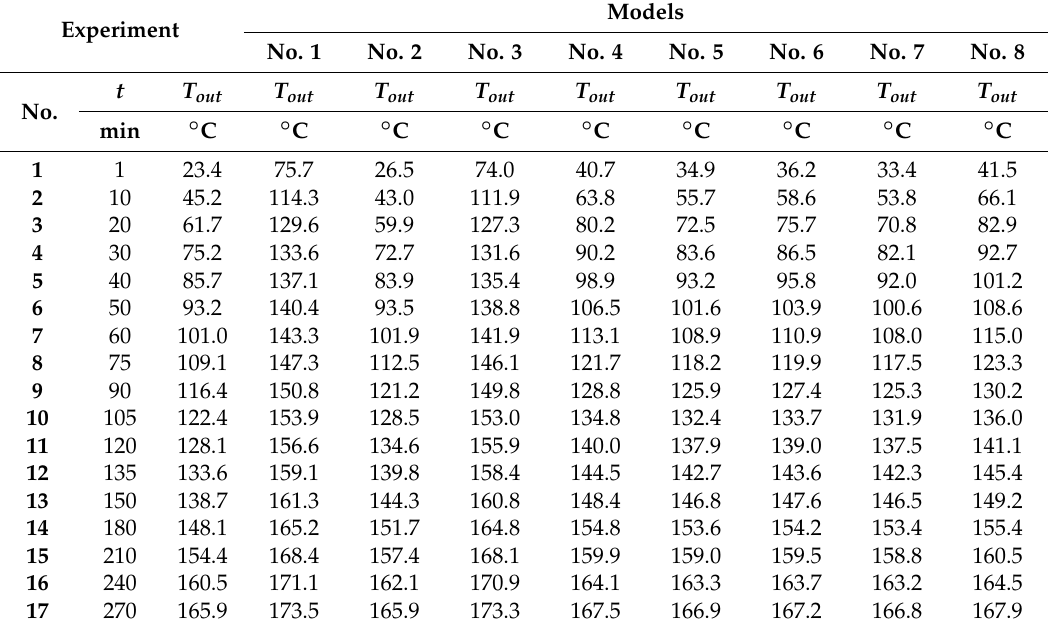
Table 5. Experiment for the airflow of 0.0068 m 3 /s.